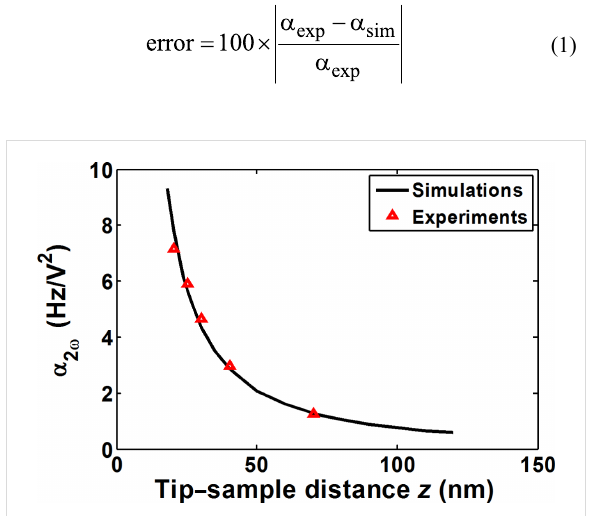
Figure 6: Tip calibration using the signal vs z curve. Experimental data fit simulations (tip radius of 29 nm and cone half-angle of 15º radius) with a total error of